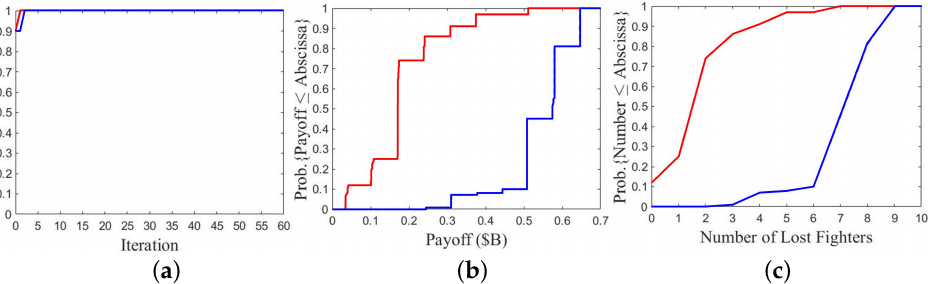
Figure 18. Specific P 2 SO run on A1/B1 over 100 games, ( a ) convergence of objective